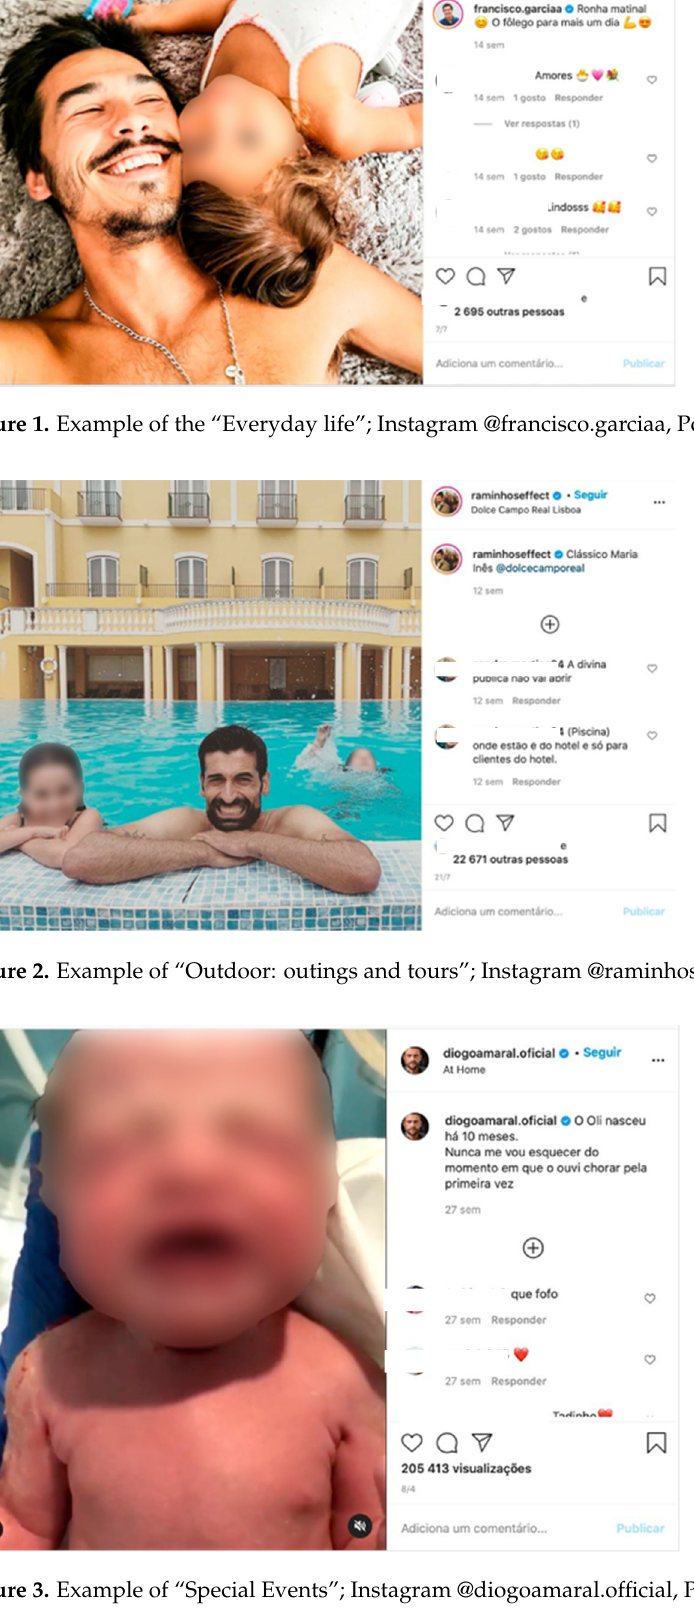
Figure 4. Example of “Advertising or Partnership”; Instagram @mafalda.sampaio, Post, 22 August 2020. Figure 5. Example of “Professional content”; Instagram @carolinapatrocinio, Post, 4 June 2020.